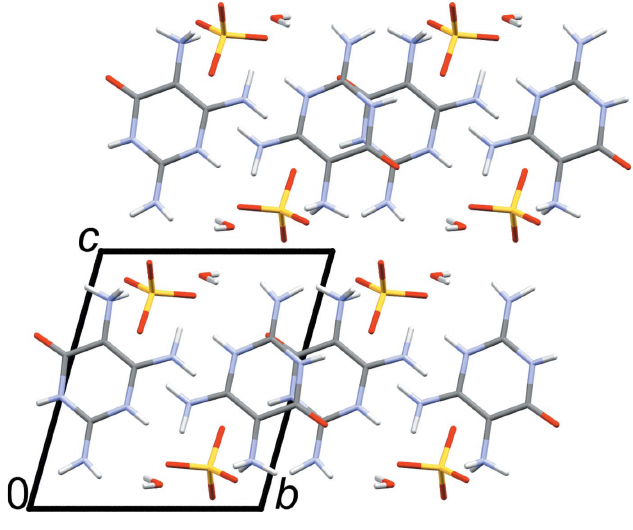
Figure 2 Partial packing diagram of the title compound viewed along the a axis.